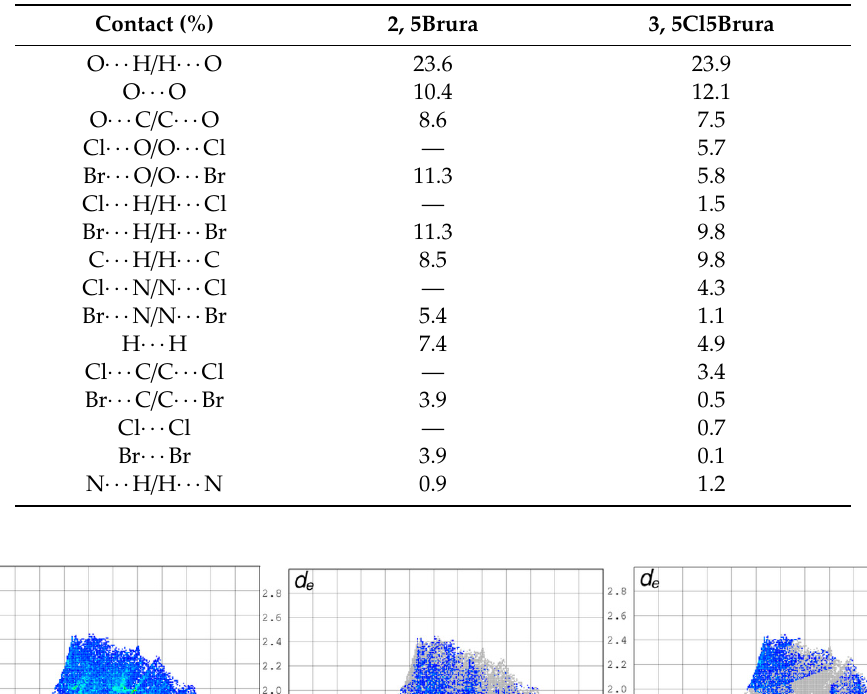
Table 5. Contributions of the intermolecular contacts for compounds 2 and